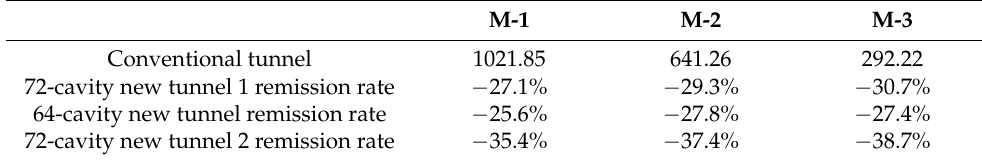
Table 5. Comparison of the effects of different options for mitigating micro-pressure